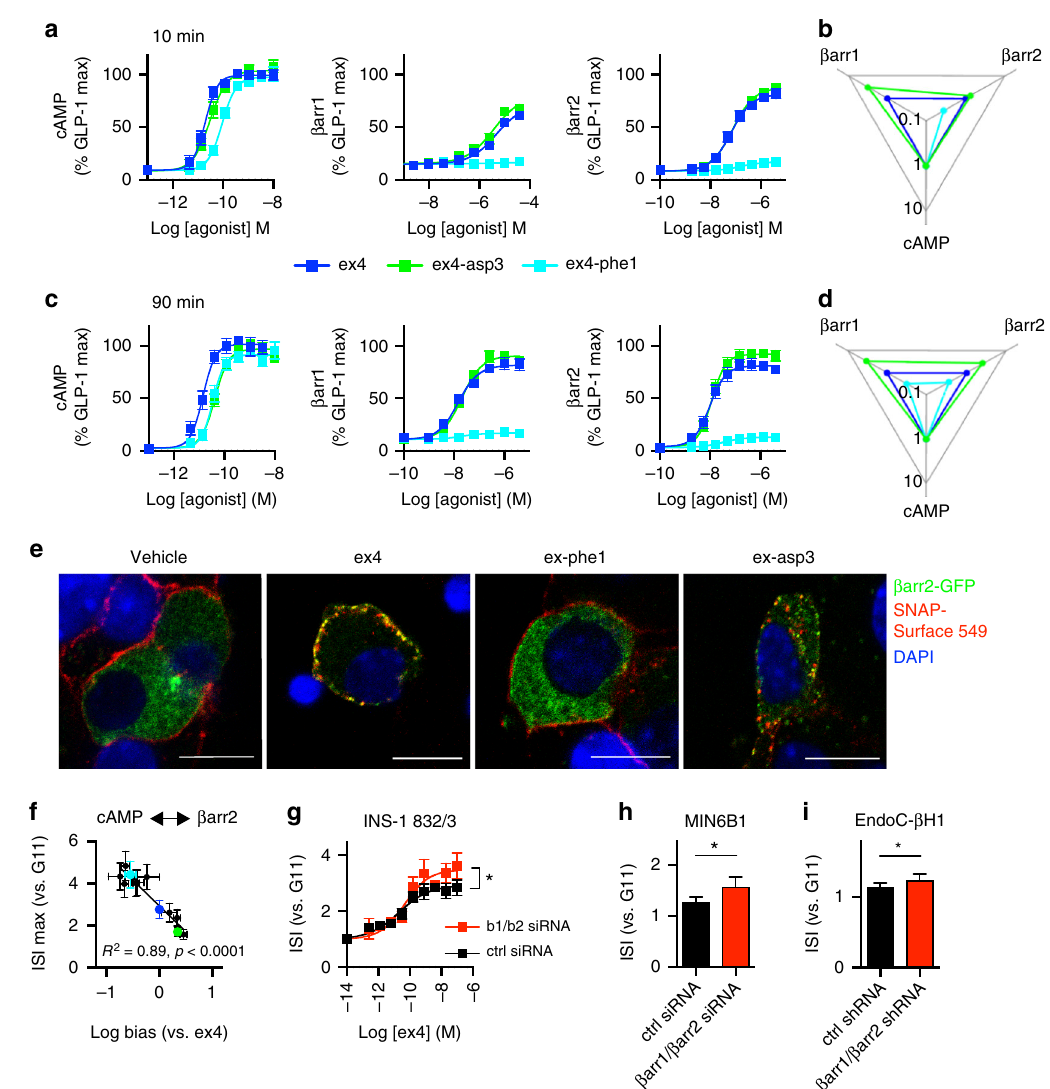
Fig. 4 β -arrestin-biased signaling reduces insulin secretion. a Agonist-induced cAMP, β -arrestin-1 ( β arr1), and β -arrestin-2 ( β arr2) responses in PathHunter CHO-GLP-1R cells, 10 min incubation, n = 4 – 6; the four-parameter logistic fi t of averaged data shown. b Web of bias, depicting relative pathway preference for each agonist; data represent the inverse logarithm of normalized log ( τ / K A ) values derived from a normalized to a reference agonist (exendin-4) and a reference pathway (cAMP); for further details, see Methods. Note that, β -arrestin-1 log ( τ / K A ) values for exendin-phe1 could not be calculated due to absence of detectable response. c , d as for a , b but for 90 min incubation. e Confocal images of MIN6B1-SNAP-GLP-1R cells transiently expressing β - arrestin-2-GFP, labeled with SNAP-Surface-549, and treated with indicated agonist for 5 min before fi xation, representative images from n = 2 experiments; scale bars, 10 μ m. Individual red and green channels shown in Supplementary Fig. 12. f Relationship between biased signaling (Supplementary Fig. 6) in PathHunter CHO-GLP-1R cells and maximal prolonged insulin secretion (Supplementary Fig. 1) in INS-1 832/3 cells. Association quanti fi ed by linear regression. g Effect of dual β -arrestin silencing on prolonged (16 h) exendin-4-induced insulin secretion in INS-1 832/3 cells, n = 4, paired t -test comparing E max . h As for g , but in MIN6B1 cells, n = 5, paired t -test. i As for g , but in EndoC- β H1 cells with stable knockdown of β -arrestin-1 and -2 by lentiviral transduction of shRNAs, n = 5, paired t -test. Agonists applied at 100 nM, except where indicated. * p < 0.05, by statistical test indicated above. Error bars indicate observations may explain the contrasting recycling patterns of (Fig. 5j, k). In contrast to its known potentiating effect on insulin exendin-phe1 vs. exendin-asp3. secretion with the GLP-1 metabolite and weak agonist GLP-1(9- To explore through an alternative strategy whether GLP-1R 36)NH 2 46 , BETP paradoxically reduced the exendin-4-induced insulin secretion with prolonged incubations (Fig. 5l). This did binding kinetics in fl uence PM recycling and insulin secretion, we not appear to be through changes to signal bias, as BETP at this utilized the GLP-1R allosteric modulator 4-(3-(benzyloxy)phe- nyl)-2-(ethylsul fi nyl)-6-(tri fl uoro-methyl)pyrimidine (BETP), dose did not affect cAMP or β -arrestin-2 recruitment responses which alters the residence time of orthosteric GLP-1R agonists 45 . (Fig. 5m, n). Therefore, via its effects on GLP-1R binding kinetics We con fi rmed that exendin-4 residence time is increased by and traf fi cking, BETP reduces the agonist responsiveness when BETP, without changes in the association rate (Fig. 5h, i). In exposed for extended periods. This observation holds implica- CHO-SNAP-GLP-1R cells, BETP slowed GLP-1R recycling after tions for the design and therapeutic use of positive GLP-1R exendin-4 exposure, with minimal effect on internalization allosteric modulators.